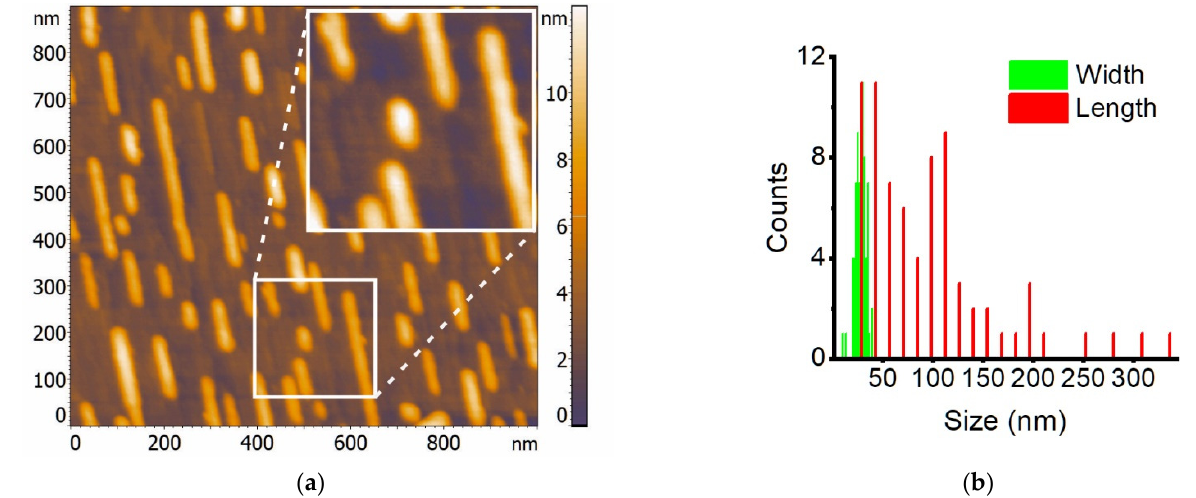
Figure 1. ( a ) AFM image of α -FeSi 2 nanorods on a Si(111)-4° vicinal surface; a square with a white border is highlighted and its enlarged image is shown in the inset; ( b ) size distribution of nanorods.